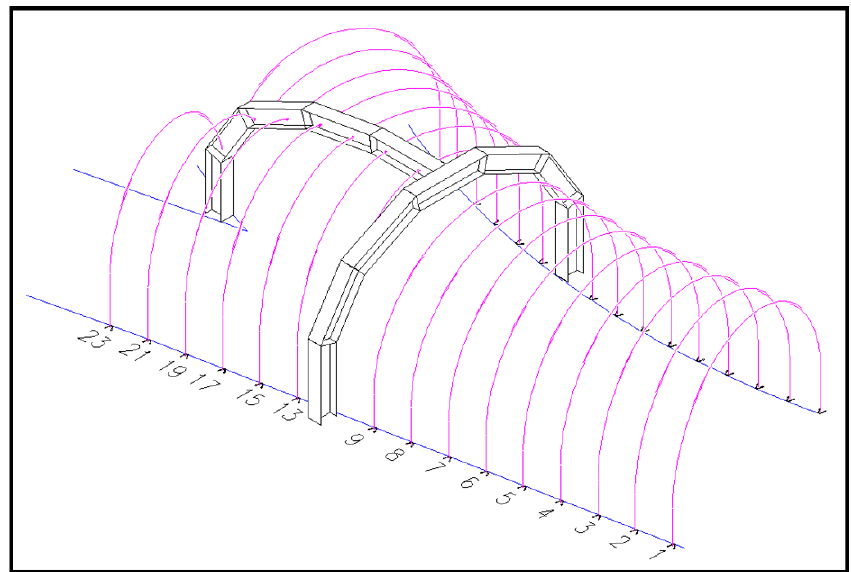
Figure 21. A simplified view of completed support of underground transportation cross-road.